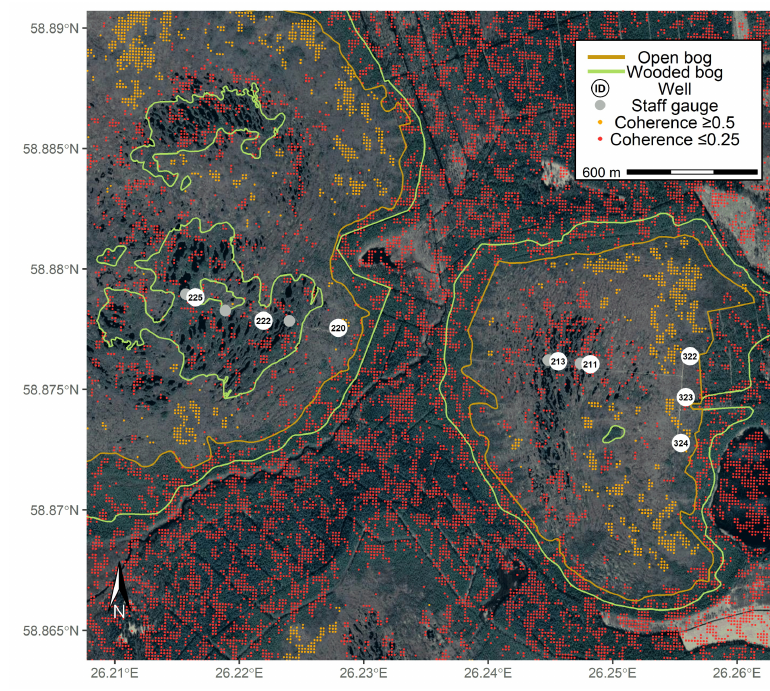
Figure 7. The location of coherent and non-coherent pixels in the landscape near the transect of water level measurements in Männikjärve bog and south-eastern part of Linnusaare bog in Endla mire complex. Pixels with the mean coherence ≥ 0.5 and ≤ 0.25 over the full stack are marked with red and orange points, respectively. Sampling wells are labeled with the well ID in a white circle and staff gauges with gray circle. Land cover classes are the same as in Figure